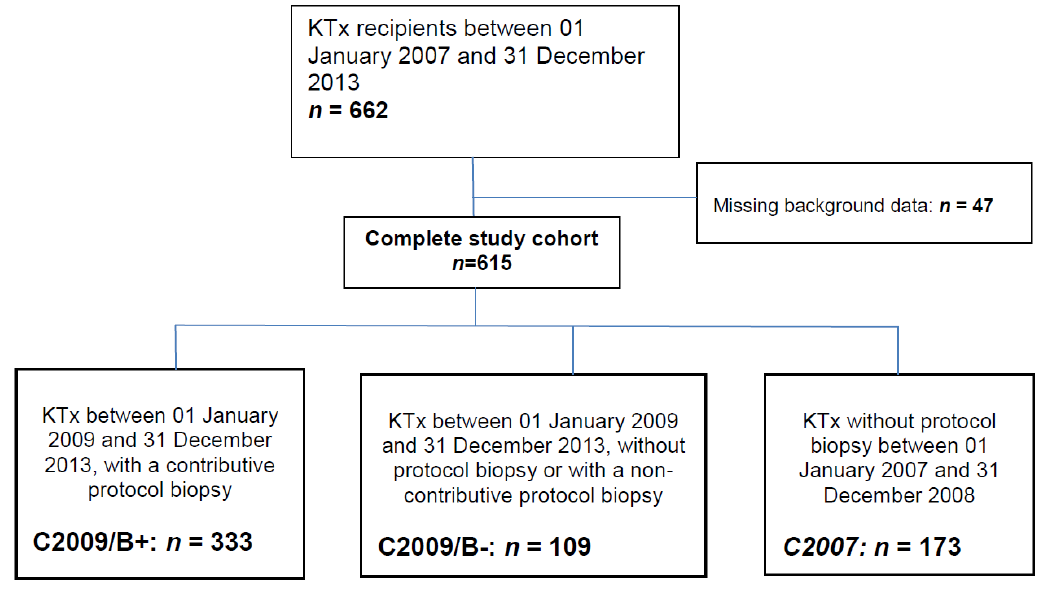
Figure 1. Study Figure 1. Study flowchart.